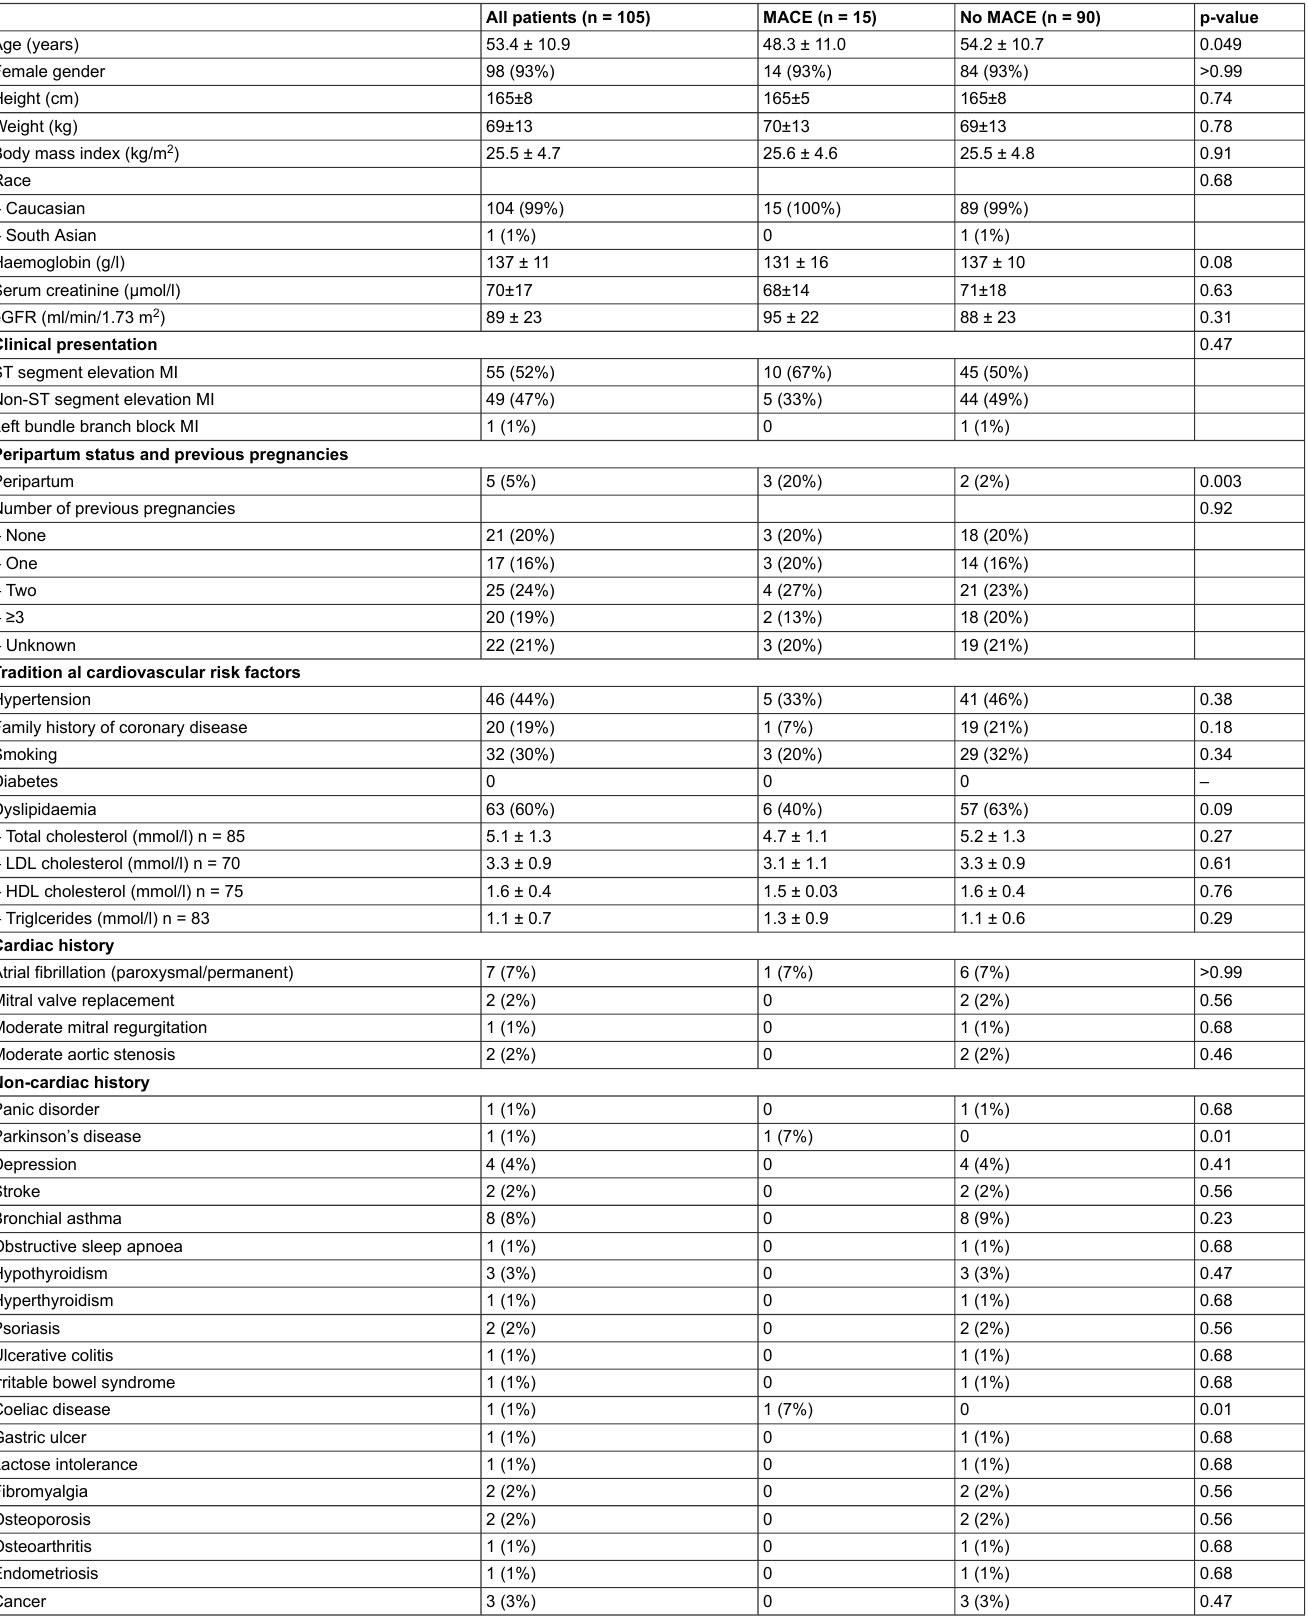
Table 1: Baseline characteristics of the study population and patient with versus without a major cardiac event